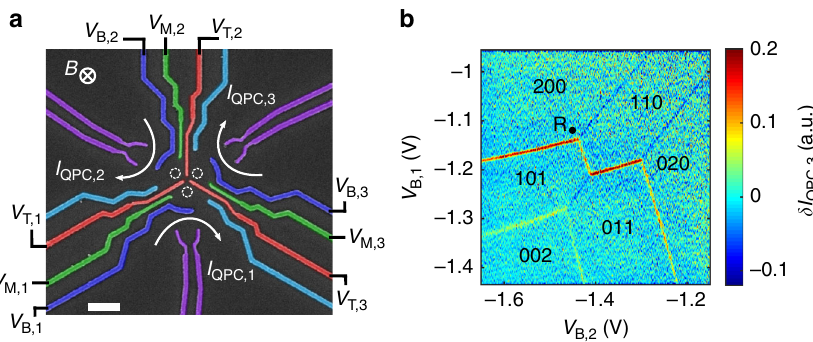
Fig. 1 Triple dot system in a circular geometry. a Scanning electron microscope image of the circular triple dot sample. The position of the dots is shown in white dashed circles . The voltages applied on the green ( V M,1 , V M,2 , V M,3 ), red ( V T,1 , V T,2 , V T,3 ) and blue gates ( V B,1 , V B,2 , V B,3 ) allow to predominantly control the coupling between the dots, the coupling to the reservoirs and the dot-chemical potentials, respectively. The purple gates are used to de fi ne sensing dots to probe, with I QPC,1 , I QPC,2 and I QPC,3 , the charge con fi guration of the triple-dot system. Electron loading and spin read-out are realized in the bottom dot . A magnetic fi eld B is applied perpendicular to the sample. Scale bar is 300 nm. b Derivative δ I QPC,3 of I QPC,3 along V B,1 when the system is scanned in the two-electron isolated con fi guration with the gates V B,1 and V B,2 . The label ( N 1 , N 2 , N 3 ) corresponds to the number of electrons in the bottom , top left and top right dots ,